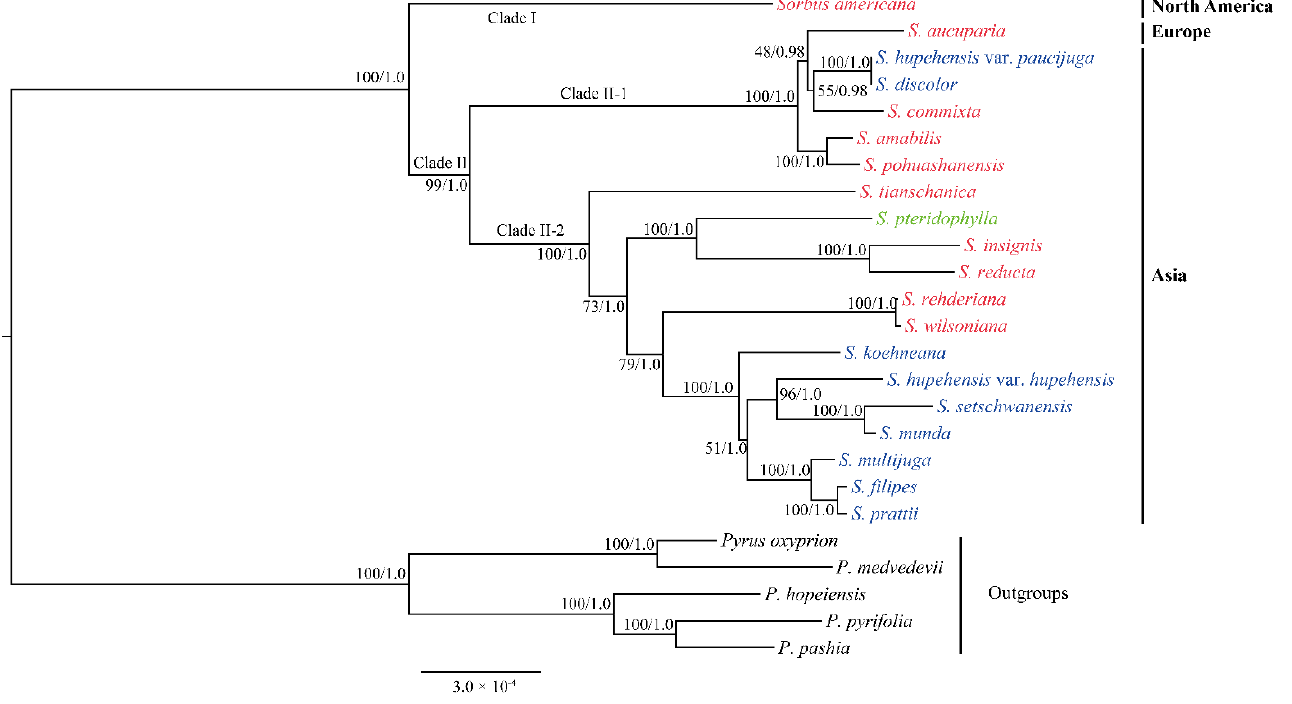
Figure 6. The phylogenetic tree of 20 Sorbus species based on chloroplast genome sequences. The species’ names marked with red, blue, and green indicate that the species has red or orange-red, pink, or white fruit, respectively. Numbers at nodes correspond to maximum likelihood bootstrap percentage and the posterior probability of Bayesian inference.